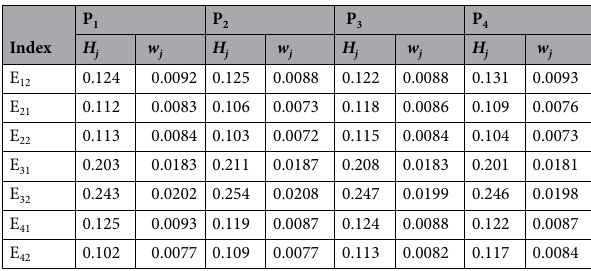
Table 2. Evaluation index entropy ( H j ) and entropy weight( w j ).